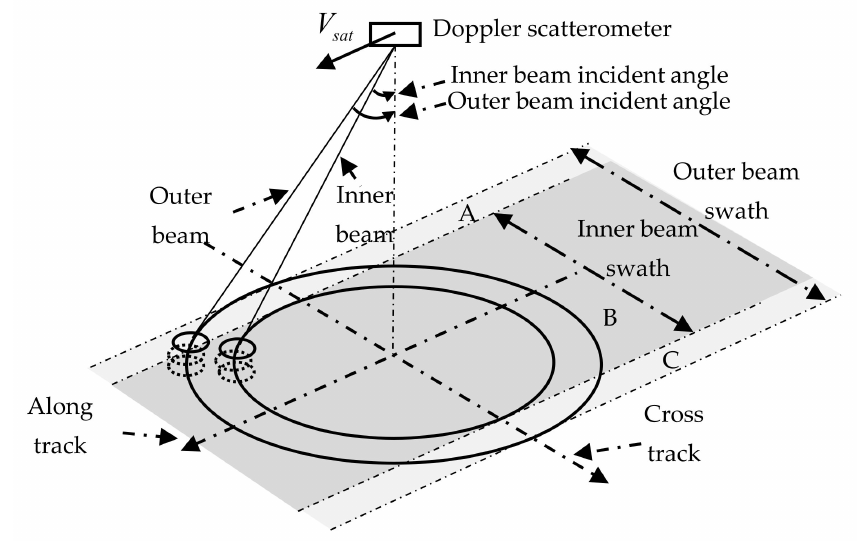
Figure 3. The pencil-beam rotating scanning